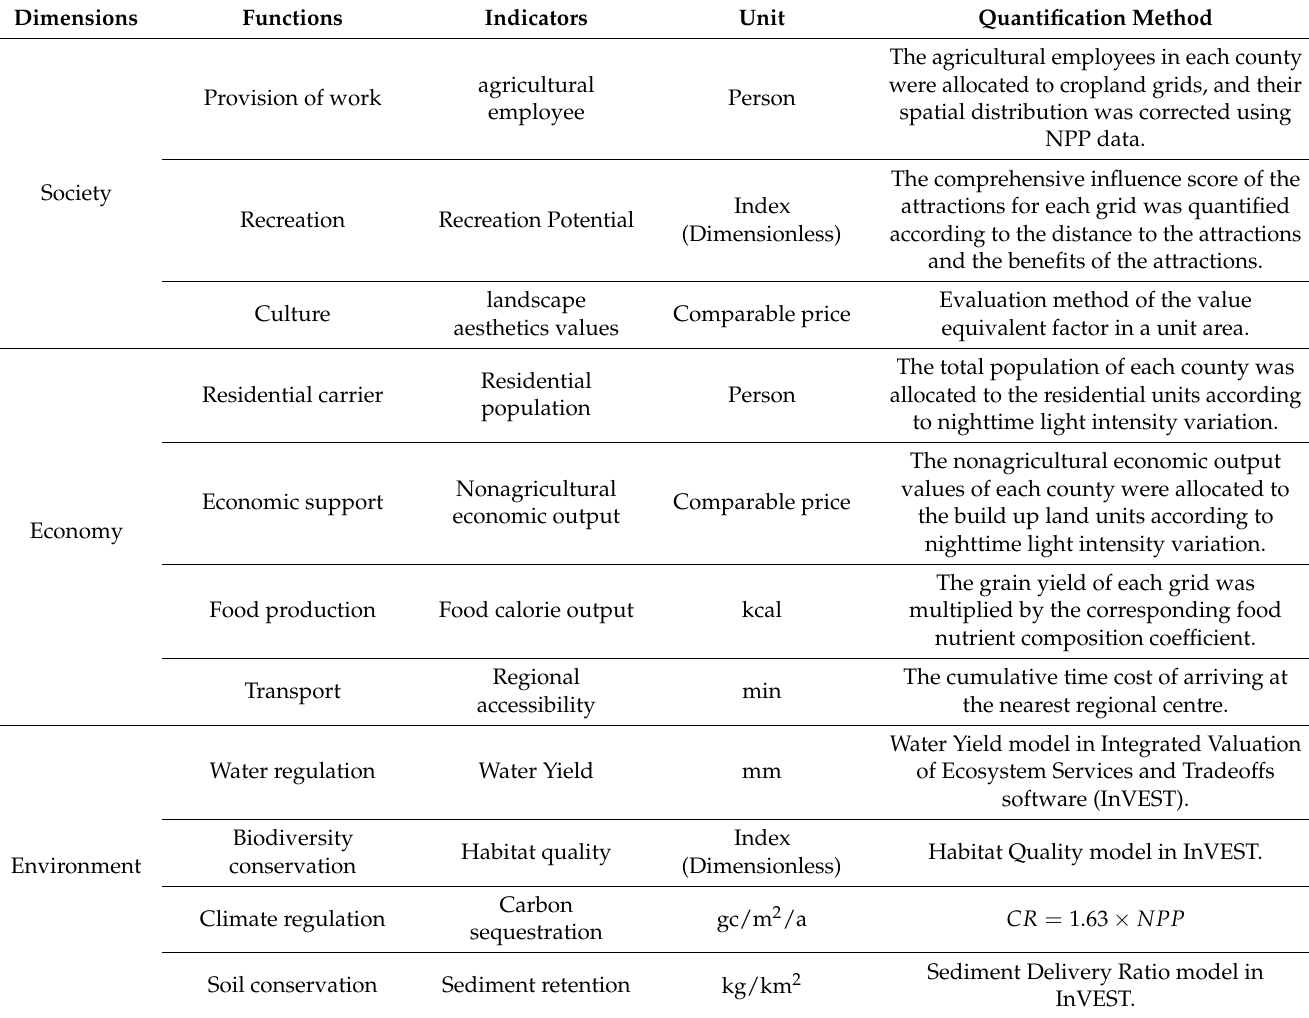
Figure 2. Classification framework of LUMF from the perspective of sustainable development. Table 1. Indicators and methods for quantifying LUFs.